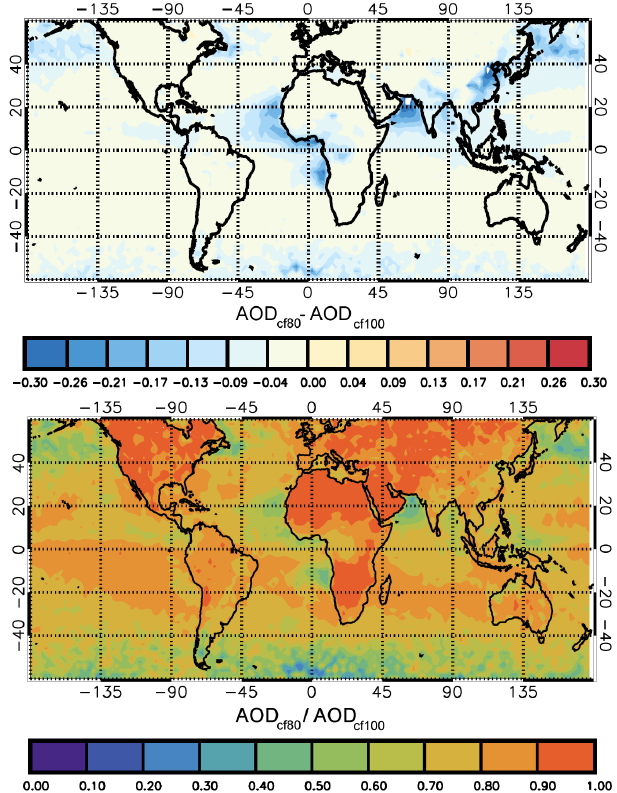
Figure 5. The absolute change (top) and fractional change (bottom) in the annual MODIS Aqua AOD (averaged over 2004–2008) when applying a filter to remove any Level 3 data that contain more than 80% cloudy Level 2